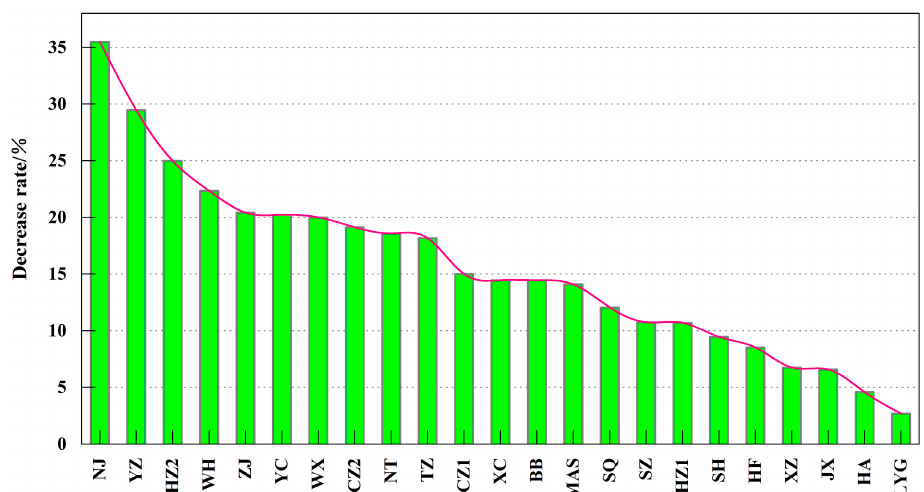
Figure 6. Decrease percentage of the AQI during the emission reduction period compared with July 2014 in Nanjing and its surrounding cities.